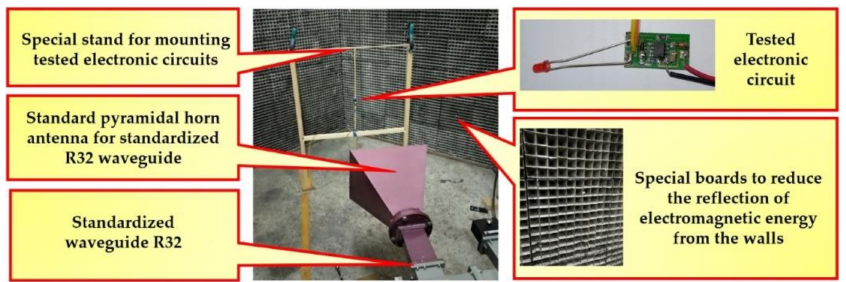
Figure 12. Special area for testing electronic devices in an electromagnetic field.